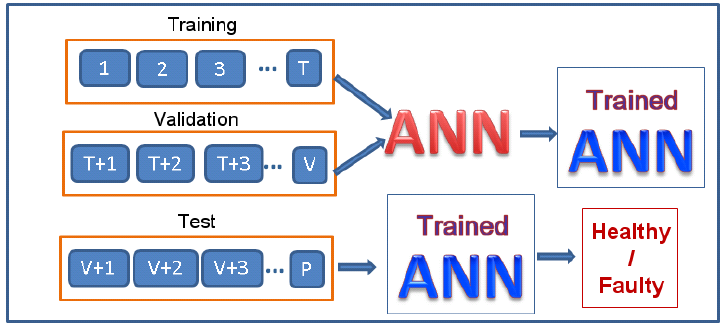
Figure 10. Scheme about training and classification for X iteration in the ‘training/validation/test cross validation’ training